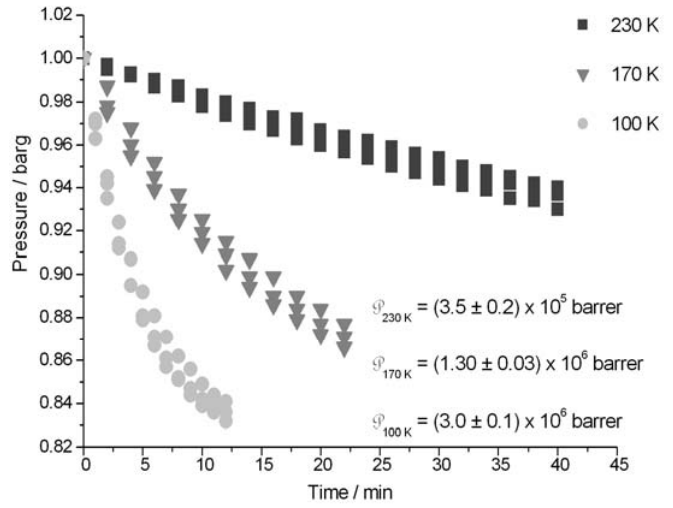
Figure 3. Temperature effect of the ice I the feed gas chamber.